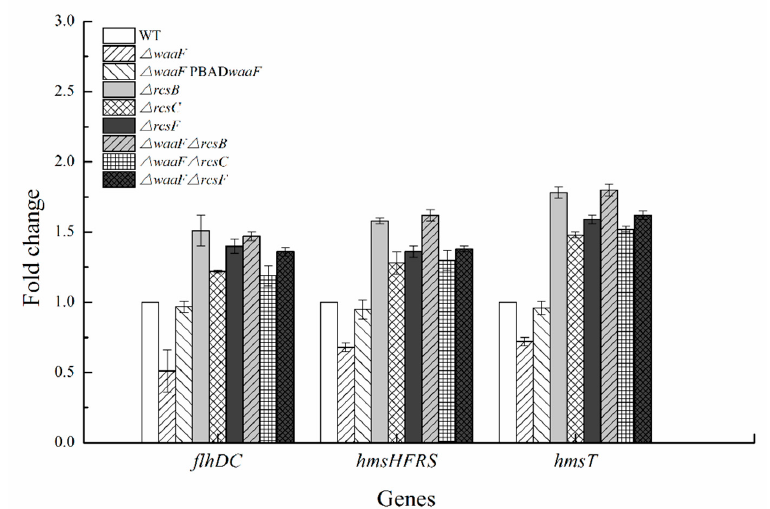
Figure 6. Transcriptional changes in the mutant strains of Y. enterocolitica . Y. enterocolitica was grown to the mid-log phase in LNNS medium, and total RNA was extracted. Expression of flhDC , hmsHFRS , and hmsT was determined by RT-qPCR in vitro. The 16S rRNA gene was used as a normalization control. Data are average values and standard deviations of triplicate experiments.